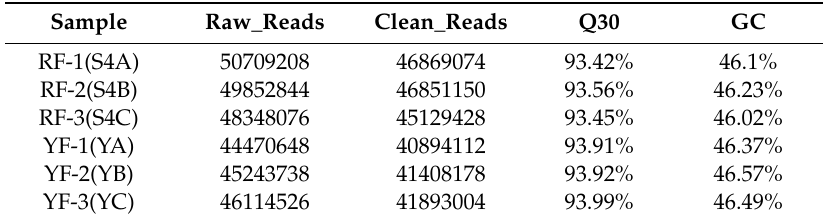
Table 2. Summary of the sequencing quality of six RNA libraries of Cerasus humilis.